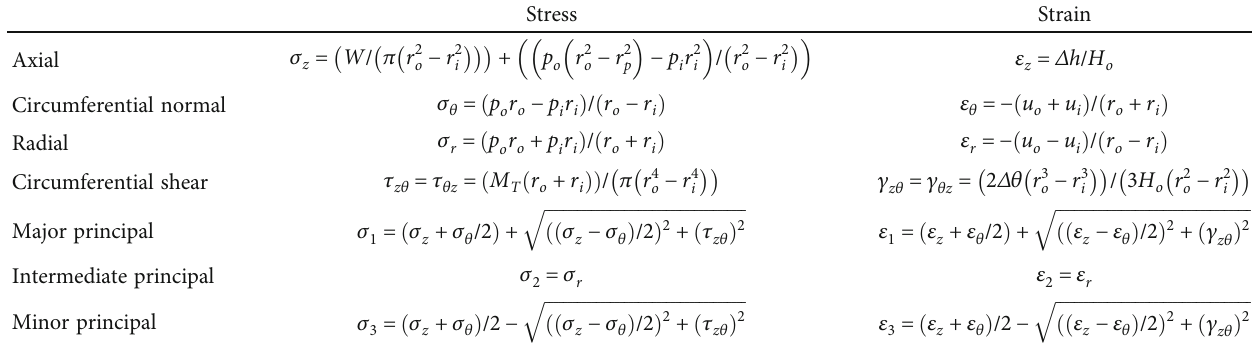
Table 1: Equations for data interpretation [39].